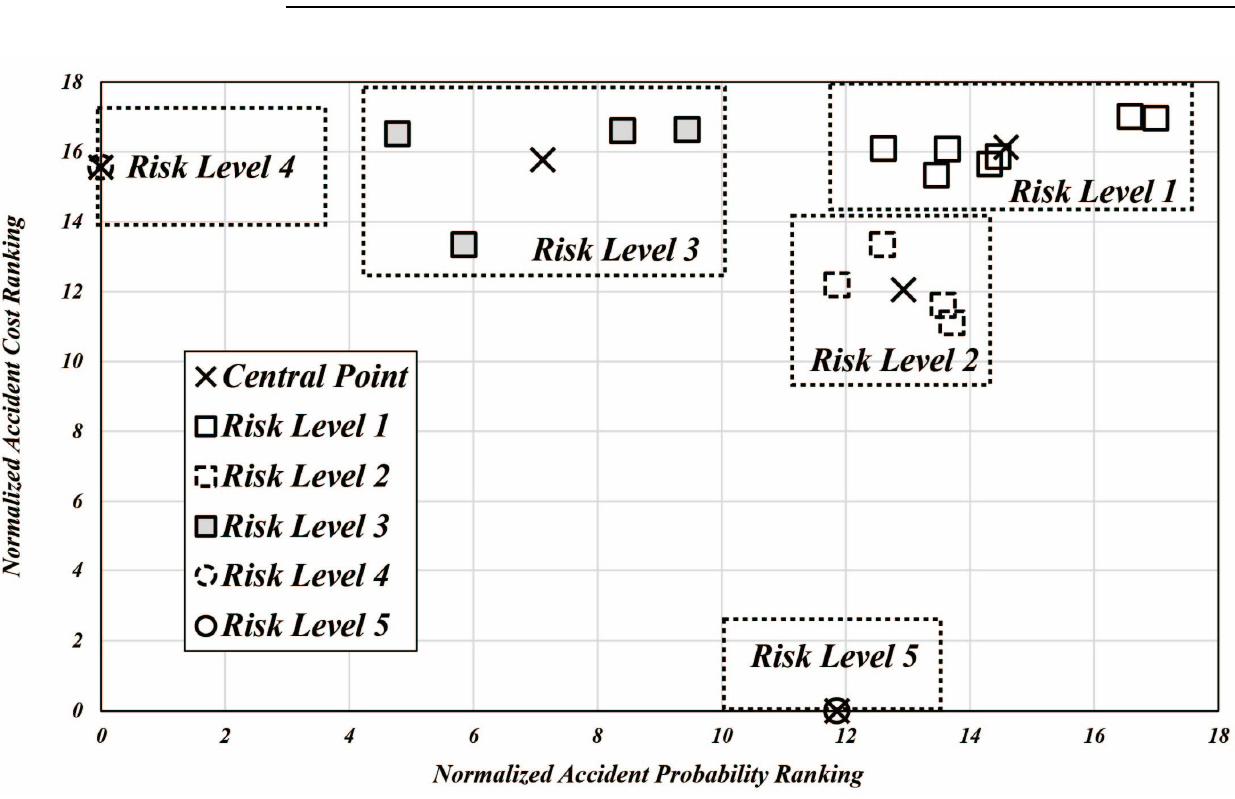
Figure 3. Clustering of risk level for 17 construction facility types.